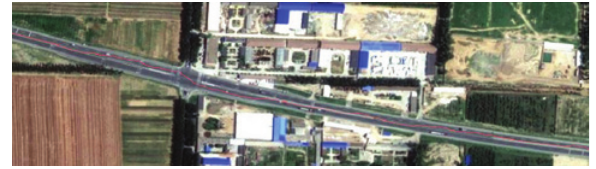
Figure 14. Extracted center line on origin